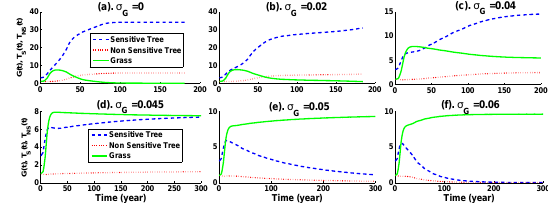
Fig. 6. From forest to grassland, with a transition through a savanna state, as a function of the sensitive tree-grass competition parameter. From left to right, the fire period τ is fixed at 4, while the grass vs. sensitive-tree competition parameter σ G increased.